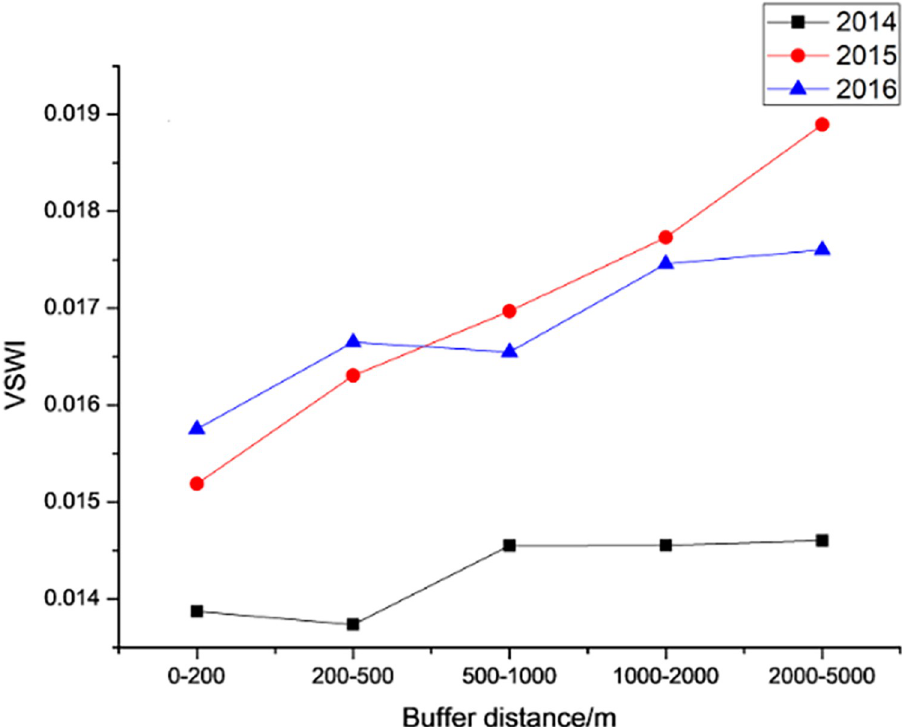
Fig 16. Changes in VSWI by buffer zone of Yongjin Expressway from 2005 to